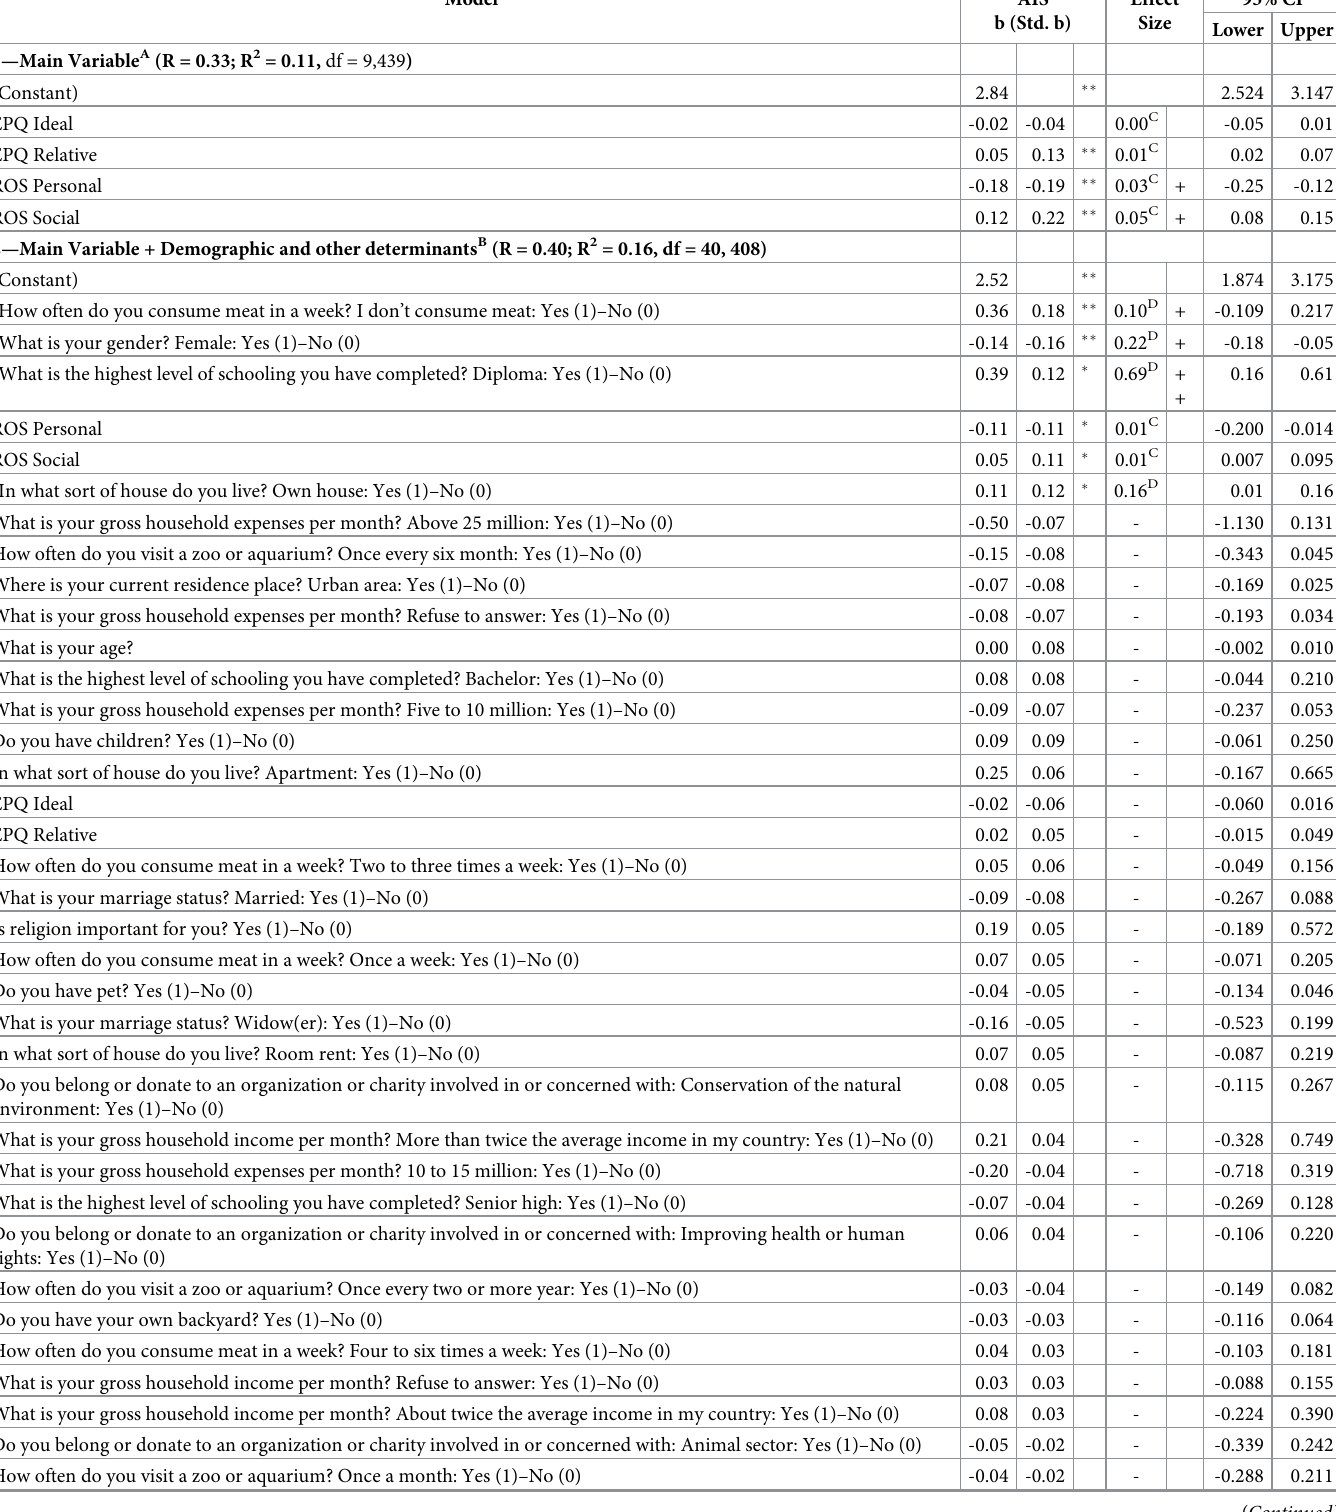
Table 7. Regression of EPQ, ROS, and demographic determinants toward